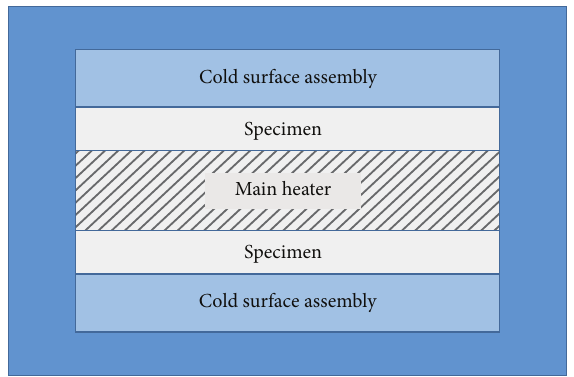
Figure 1: System mounting hot isolated plate by ASTM C177-97